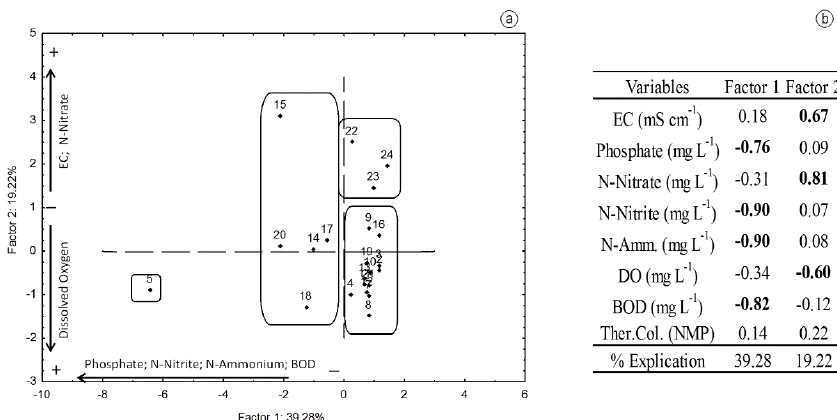
Figure 4. Principal Components Analysis of the sampling points of the Apodi/Mossoró river hydrographic basin, in the month of November of 2007. a) Representation of the two first PCA components; b) Variables correlation values. EC: Electric Conductivity; N-Amm.: Ammoniacal nitrogen; DO: Dissolved oxygen; BOD: Biochemical Oxygen Demand; Ther. Col.: Thermotolerant Coliforms.